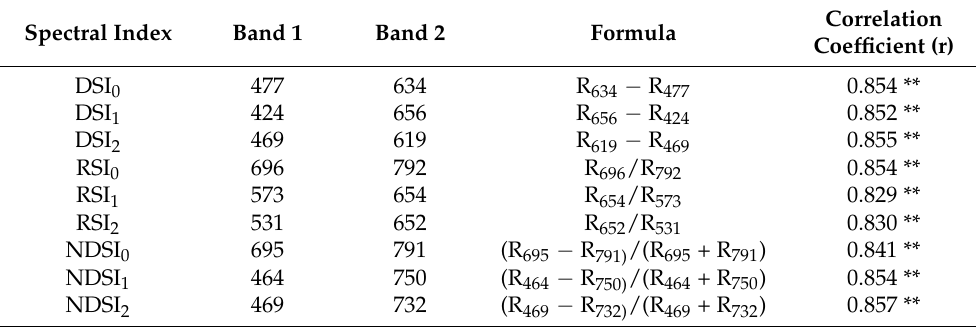
Table 2. Selected wavelengths, formulas, and the correlation coefficient between anthocyanins and the spectral index.